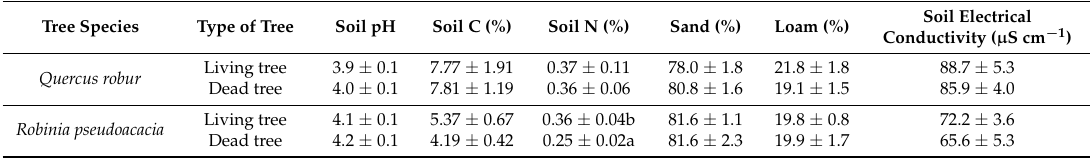
Table 4. Features of soil samples taken below living and recently dead trees of both study species. Dead oak ( Quercus robur ) trees were those used for detecting Phytophthora root rot. Different letters indicate significant ( p < 0.05) differences between the two tree types based on t